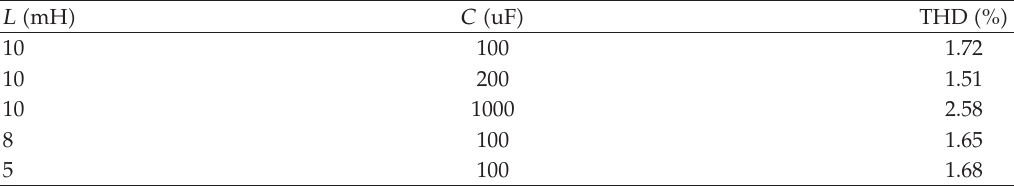
Table 1: Performance for variation in filter inductance and DC